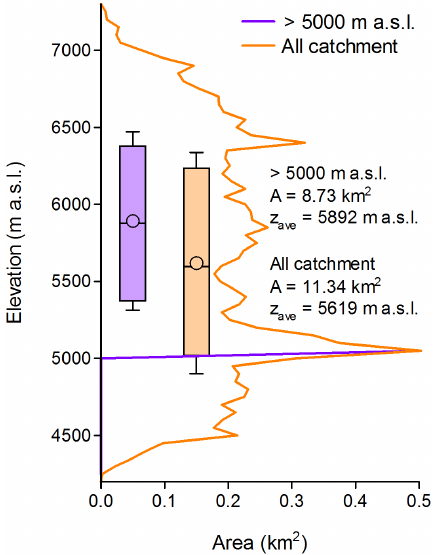
Figure 13. Hypsometry and box plot for the upper catchment above the Langtang village, from which the main avalanche might have occurred (orange polygon in Fig. 1a). Also shown is that lim- ited above 5000ma.s.l. Elevation data are from ASTER GDEM2 (Tachikawa et al., 2011). Box, line, and circle in the box-and- whisker plot denote interquartile, median and mean, and 1 standard deviation,